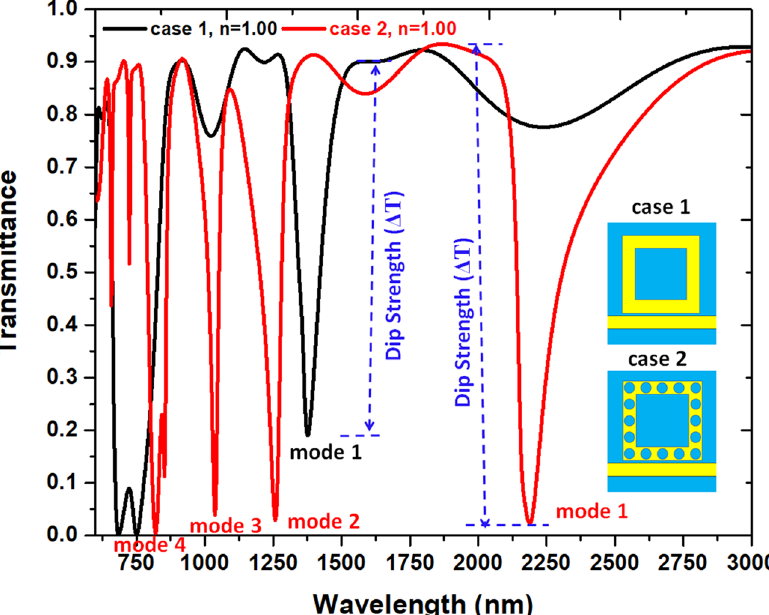
Figure 2. Comparison of the transmittance spectrum of the SPPs modes of two waveguide-cavity types, i.e., a bus waveguide coupled to one square air ring (black, denoted as case 1), and a bus waveguide coupled to one square air ring containing sixteen nanorods (with radius r ) uniformly distributed in an air ring (red, denoted as case 2). The structural parameters w, a , g , b , and r are 50 nm, 300 nm, 10 nm, 50 nm, and 20 nm, respectively.